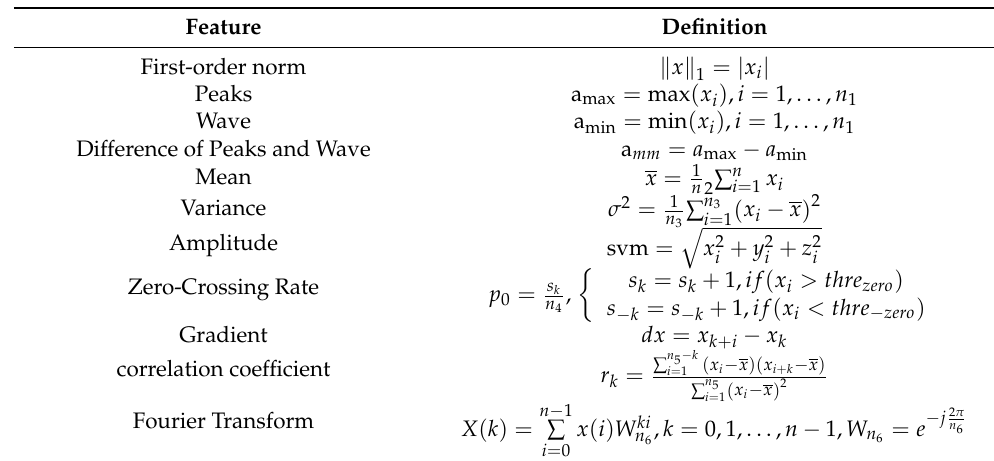
Table 2. Feature extraction in time domain and frequency domain